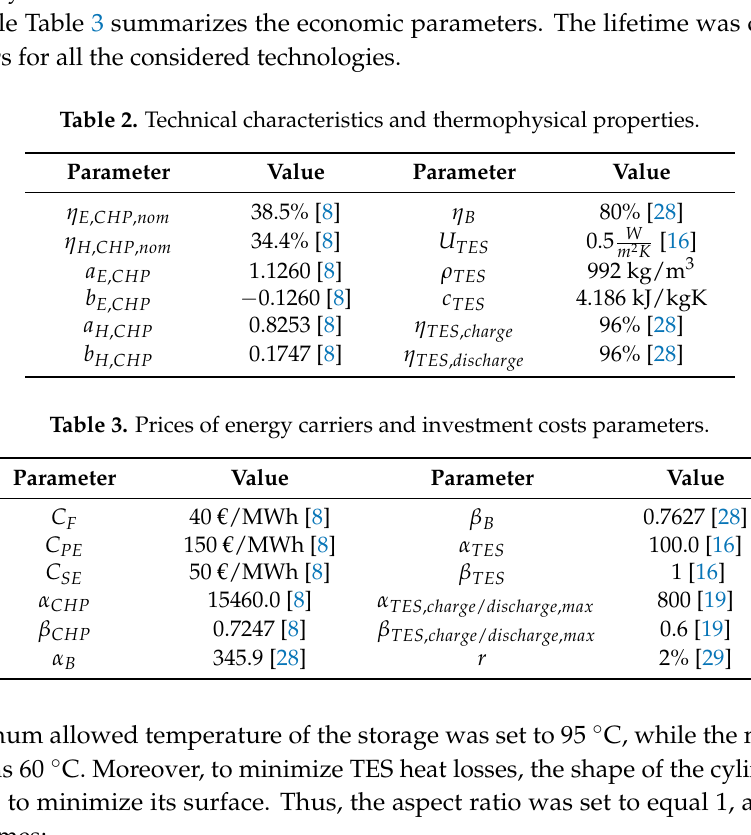
Figure 5. Hourly ambient temperature for the case study [27].